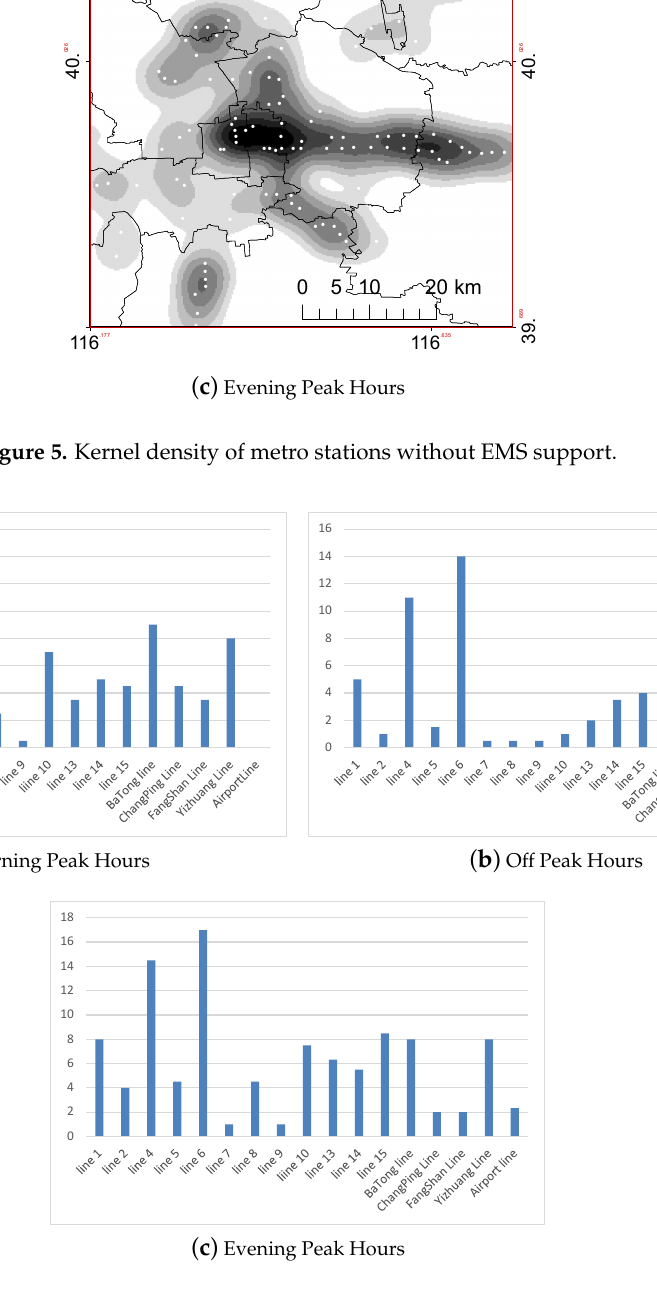
Figure 6. Metro stations without EMS support of different